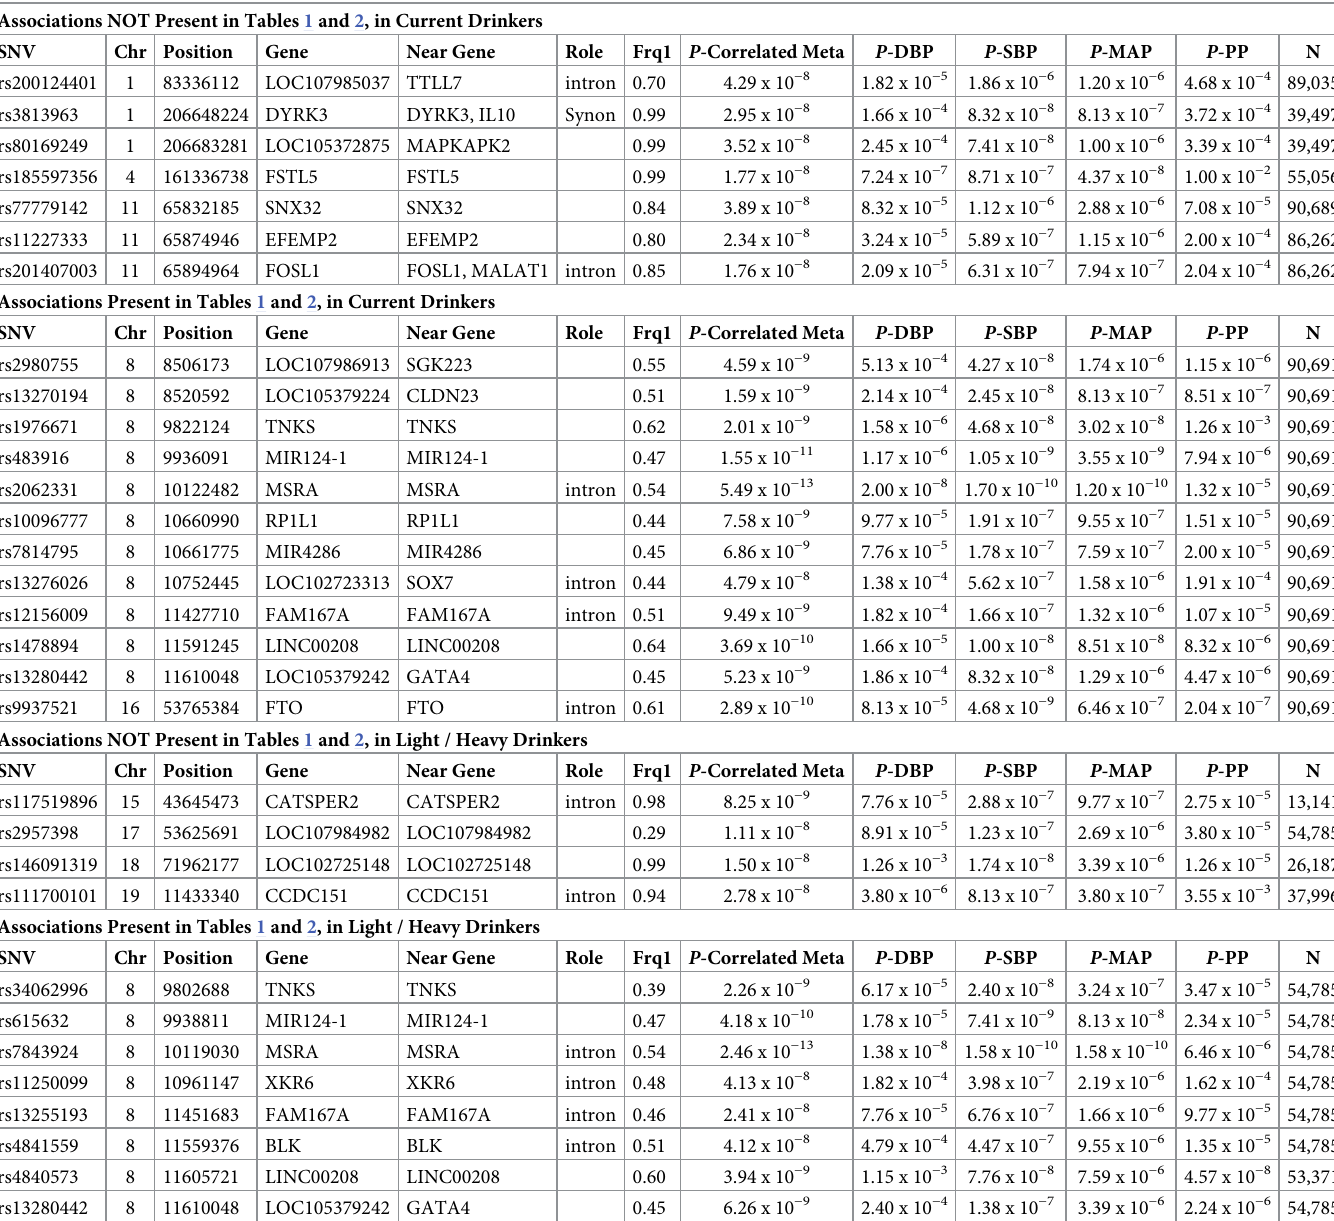
Table 5. Novel SNVs/Genes associated with BP traits from correlated meta-analysis in European ancestry in Stage 1. Associations NOT Present in Tables 1 and 2, in Current